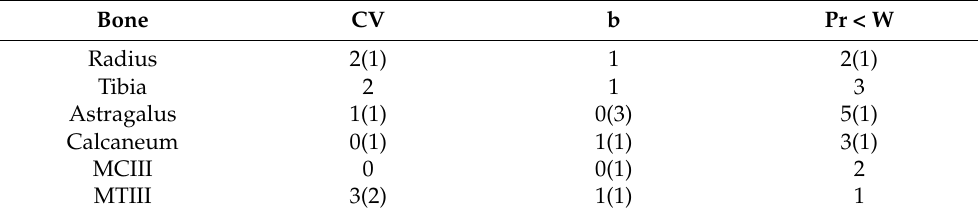
Table 7. Summary table of the number of variables that exceed the limit value for each statistical